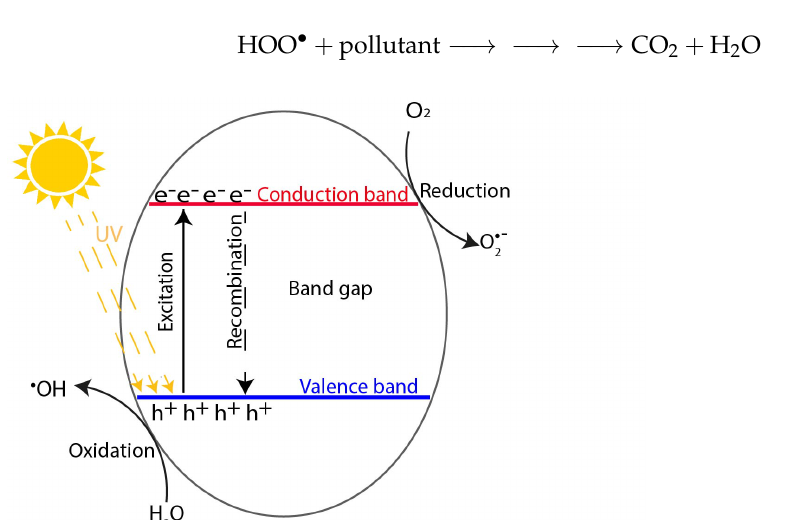
Figure 1. Principle mechanisms for charge carrier generation and consecutive reactions in a photocat- alytically active semiconductor during